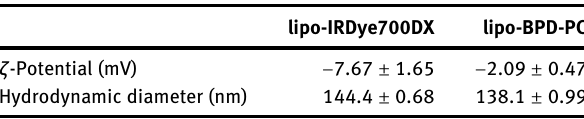
Table  : ζ -potentials and hydrodynamic diameters of lipo- IRDye  DX and lipo-BPD-PC in